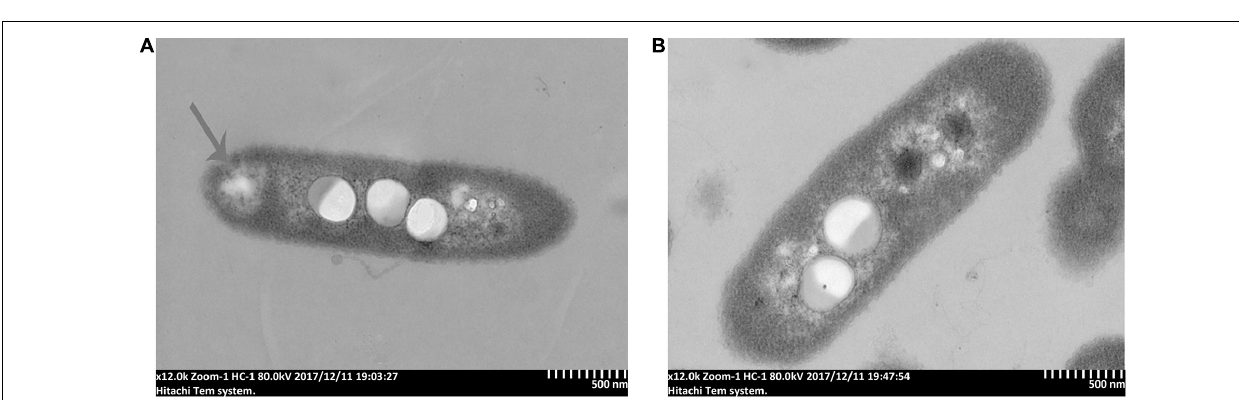
FIGURE 4 | SEM images of R. solanacearum cells treated with (A) 7-methoxycoumarin; (B) DMSO.